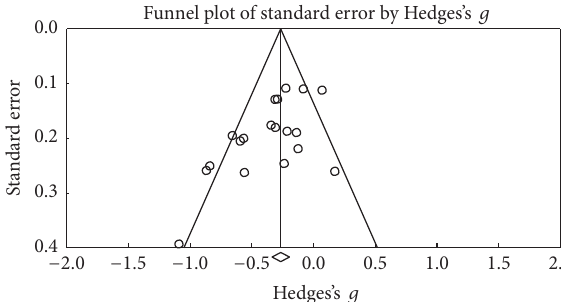
Figure 2: Funnel plot for standard error in publications of verbal